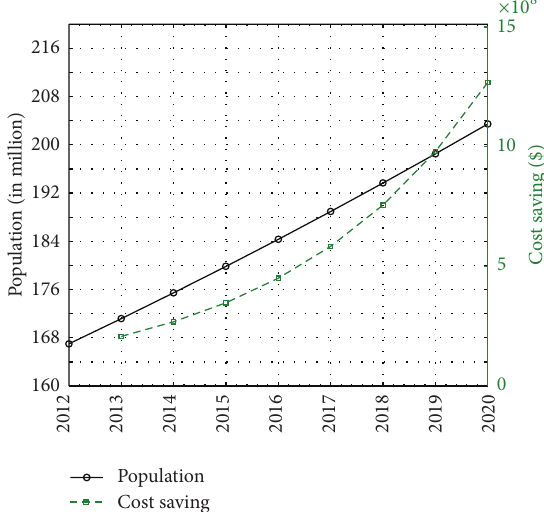
Figure 11: Comparison of the growth in cost saving and population till